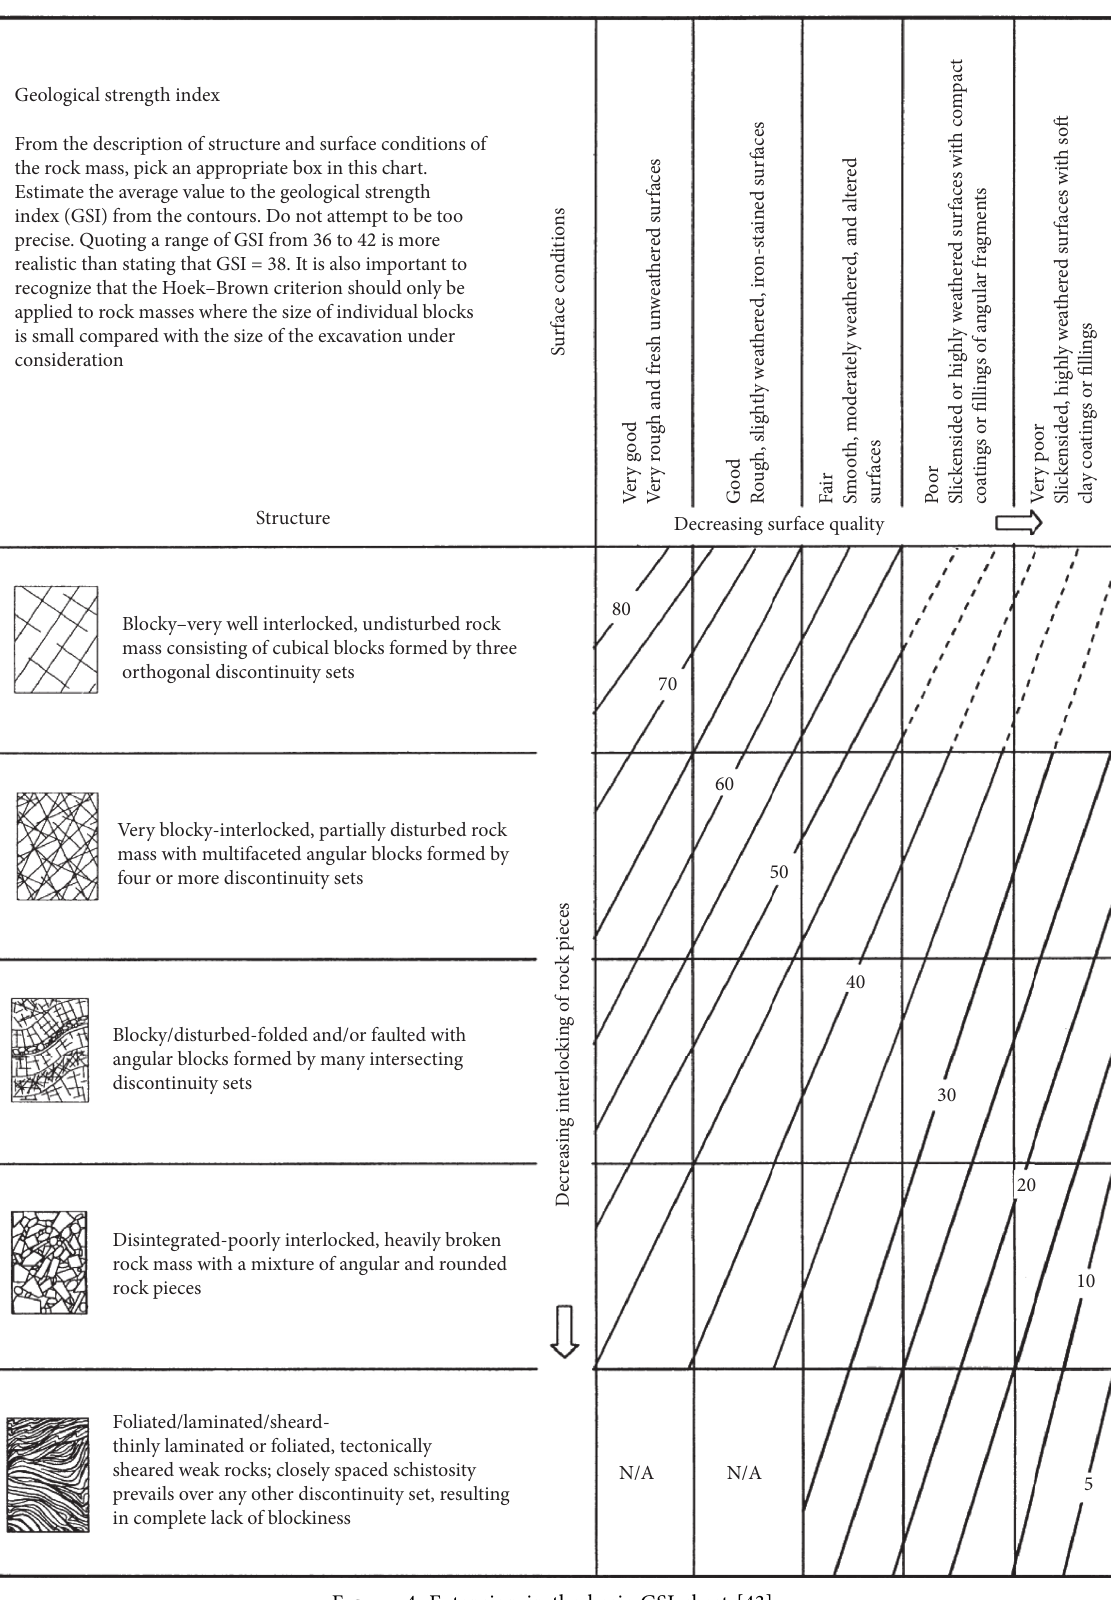
Figure 4: Extension in the basic GSI chart